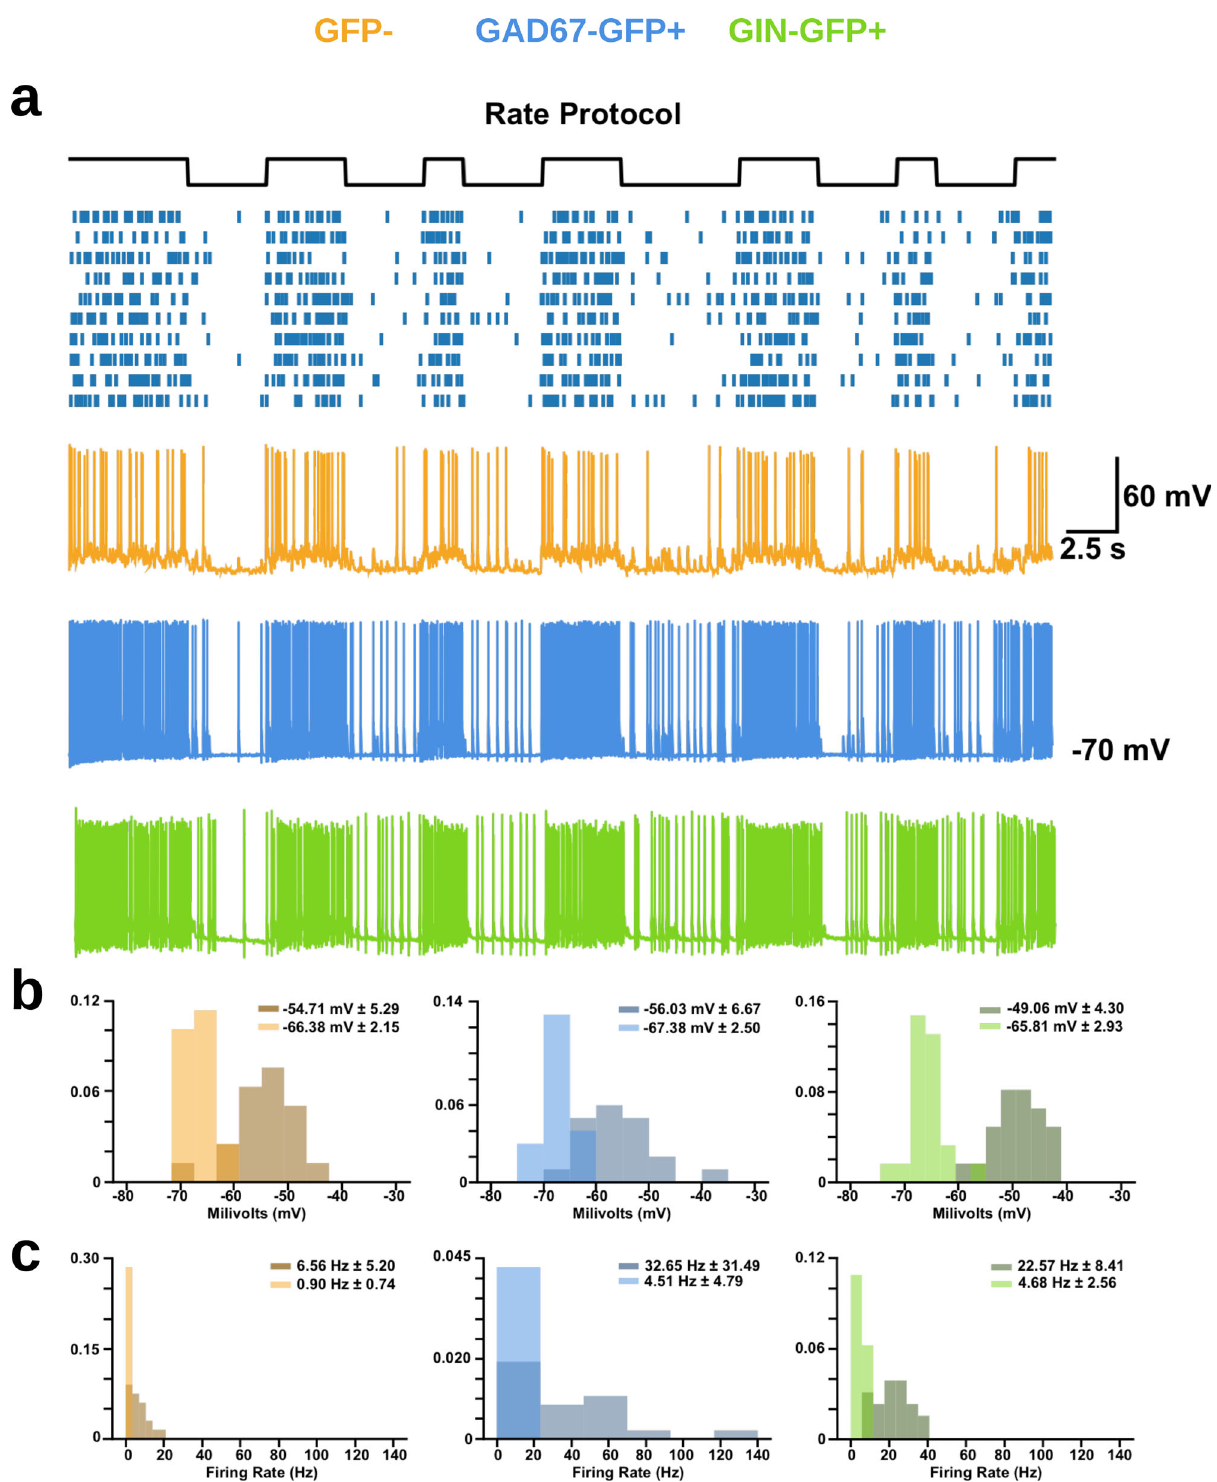
Fig. 7 High and low states within the rate encodings produced different neuronal responses. a Sample traces of each cell type to the rate encoding. b Probability density functions of the membrane potential of each cell type during high (darker histogram) and low (lighter histogram) states within the rate encodings (numbers shown represent mean membrane potential in each state ± standard deviation). 2-KS tests indicate differences in the sample distributions of average membrane potential for each cell type between the 0 and 1 state (GFP − : D(30) = 0.76, p < 0.001; GAD67-GFP: D(26) = 0.80, p < 0.001; GIN-GFP: D(30) = 0.83, p < 0.001). c Probability density functions of the fi ring frequency of each cell type during high and low states within the rate encodings (numbers shown represent mean fi ring frequency in each state ± standard deviation). 2-KS tests indicate differences in the sample distributions of average membrane potential for each cell type between the 0 and 1 state (GFP − : D(30) = 0.55, p < 0.001; GAD67-GFP: D(26) = 0.52, p < 0.001; GIN- GFP: D(30) = 0.73, p <